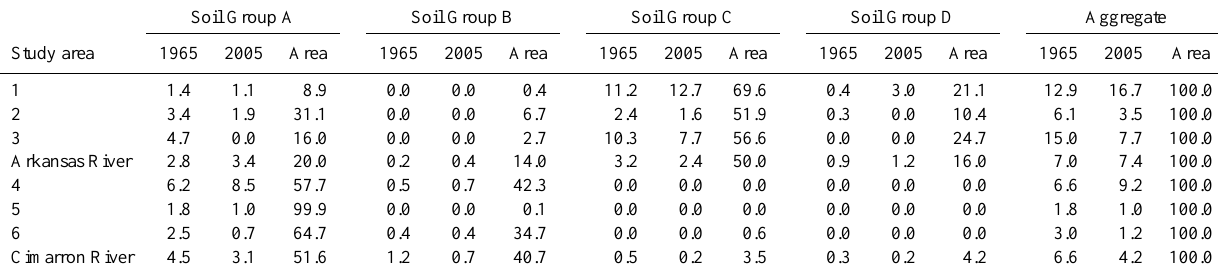
Table 3. The percent of phreatophyte canopy area over soil classes in pre-development and post-development times. Soil Group A Soil Group B Soil Group C Soil Group D Aggregate Study area